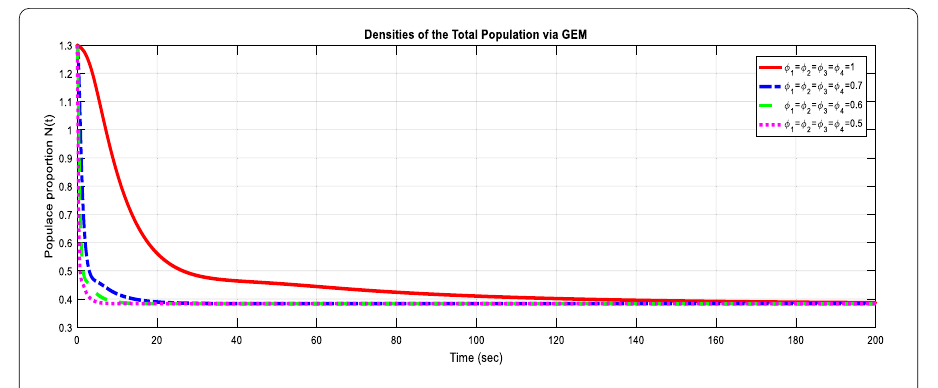
Figure 9 Dynamic of N by varying the value of φ